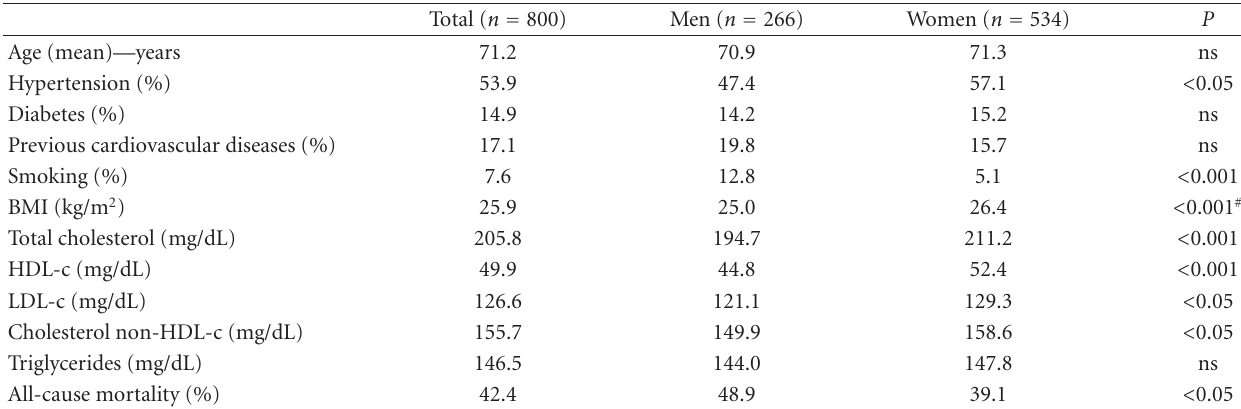
Table 1: Characterization of older people according to